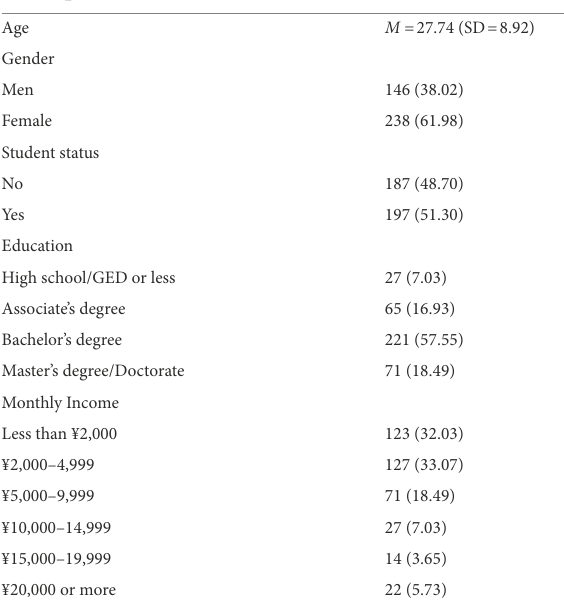
TABLE 1 Characteristics of participants. Participant